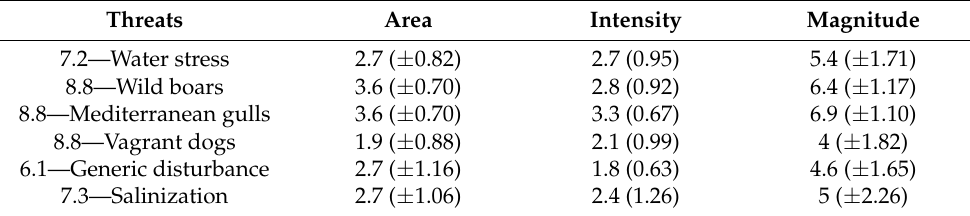
Table 1. Threat Analysis (TAN) procedure. Mean values (and ± standard deviation) in regime attributes (area, intensity and magnitude) for the six human-induced direct threats selected in the Diaccia Botrona